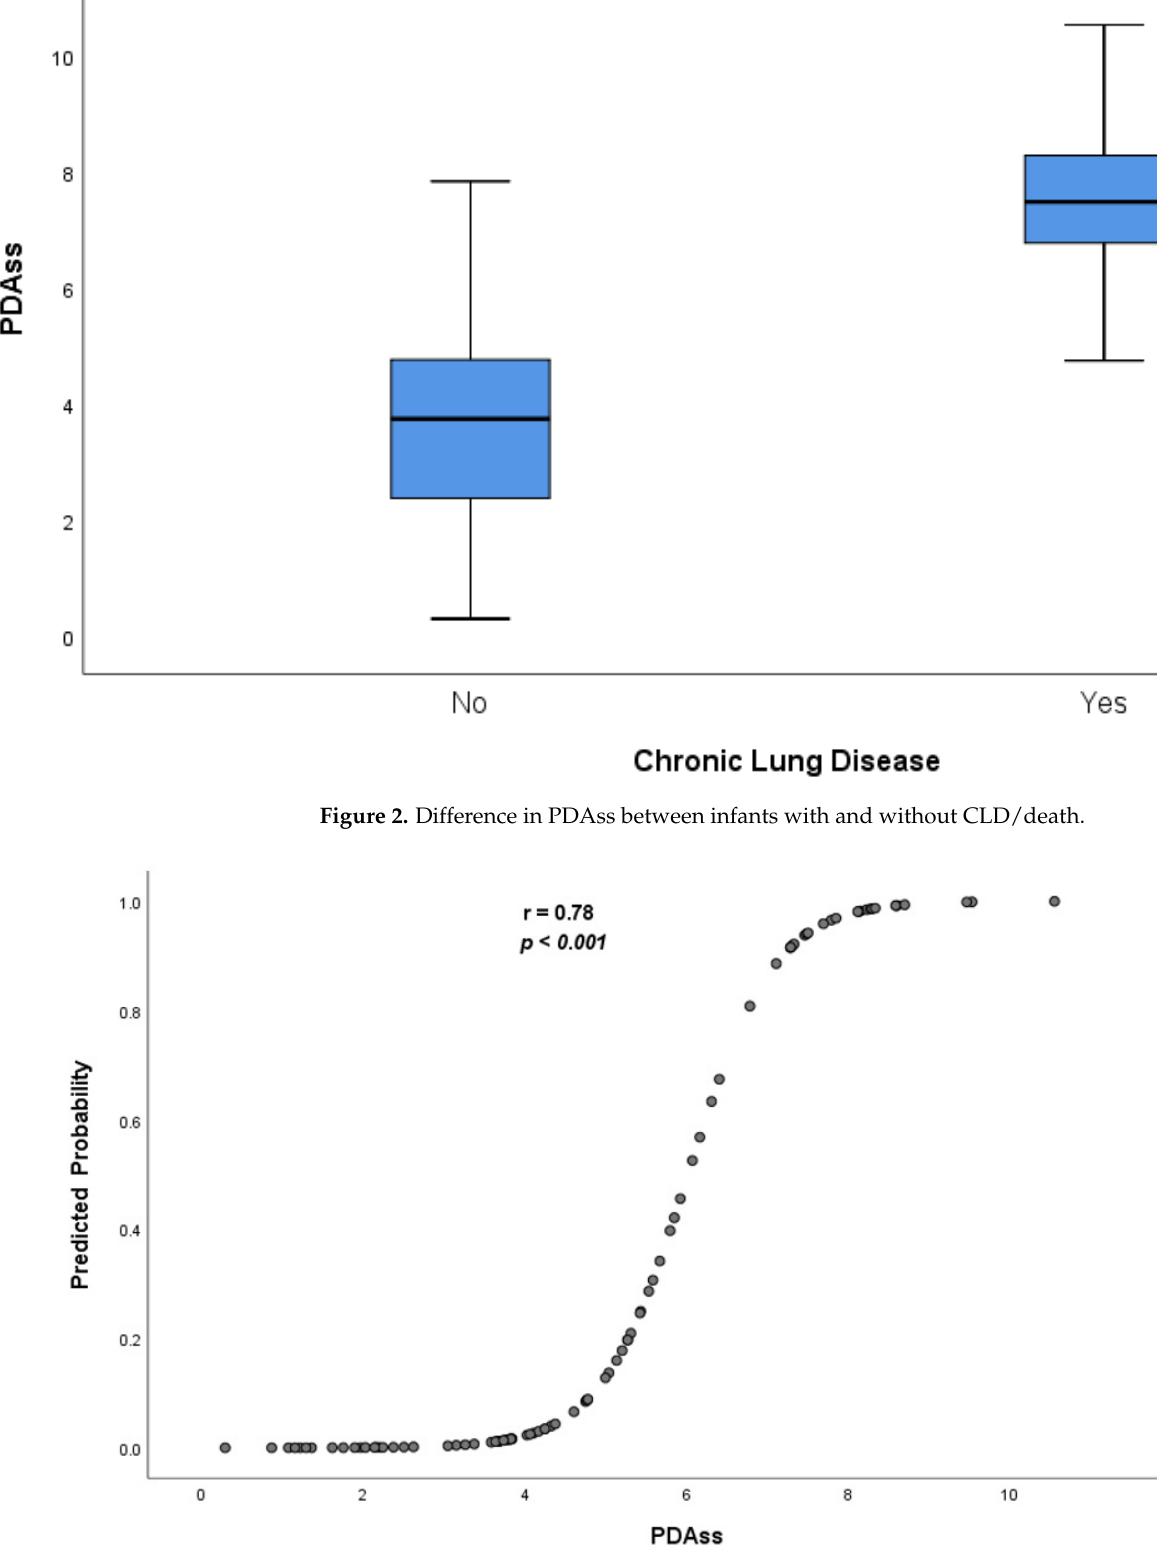
Figure 3. Relationship between PDAss and predicted probability of CLD/death of the entire cohort.